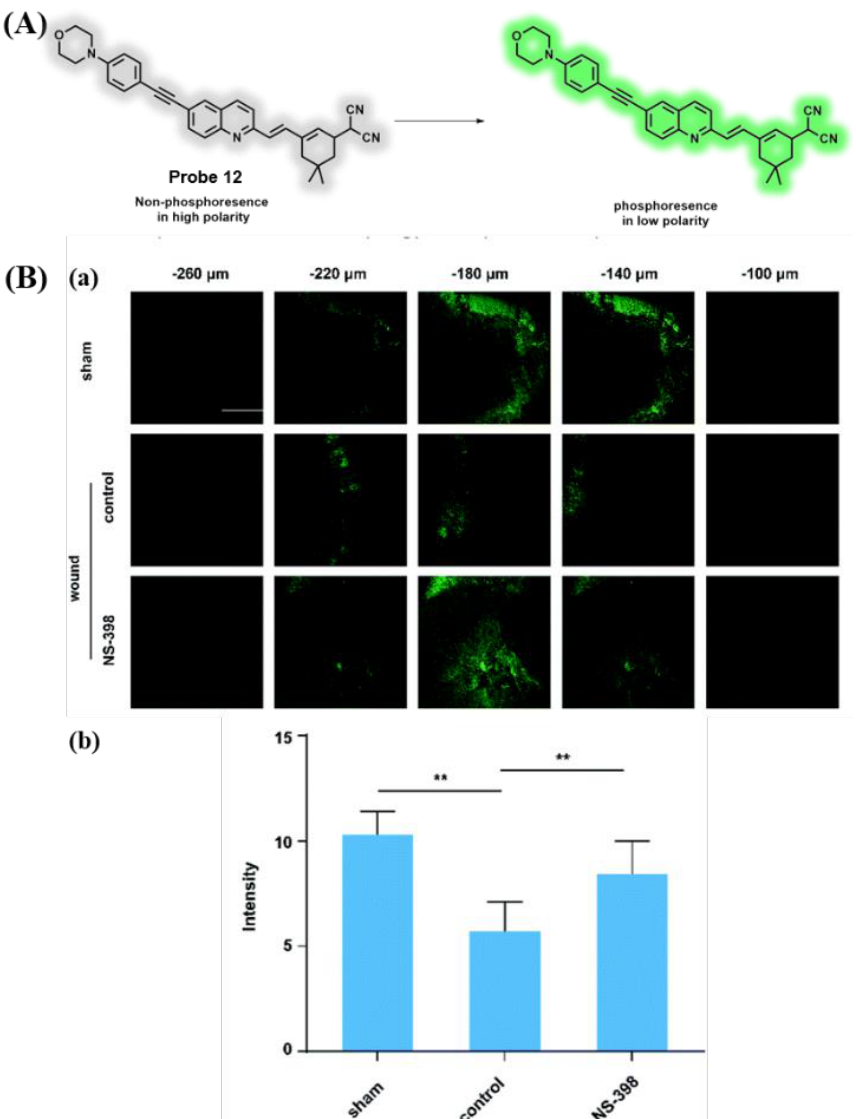
Figure 10. ( A ) Imaging mechanism of probe 12 ; ( B - a ) in situ TP fluorescence imaging of 12 -loaded (200 μL, 100 μM) wound healing tissue in diabetic mice under different treatments ; ( B - b ) averaged fluorescence changes of ( B - a ). Difference was analyzed by one-way ANOVA, ** p < 0.01. Scale bars: 200 μm. Adapted from Reference [73]. Copyright 2022, the Royal Society of Chemistry.